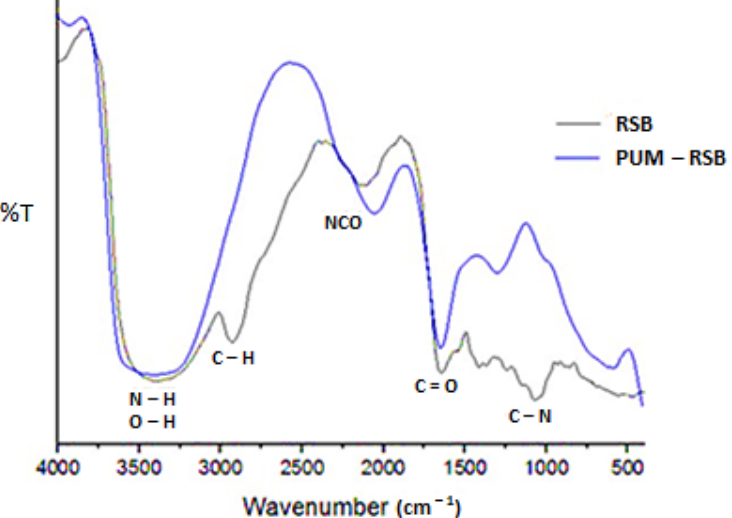
Figure 2. FTIR spectrum of red seaweed biomass (RSB) and polyurethane membrane from red seaweed biomass (PUM-RSB) .